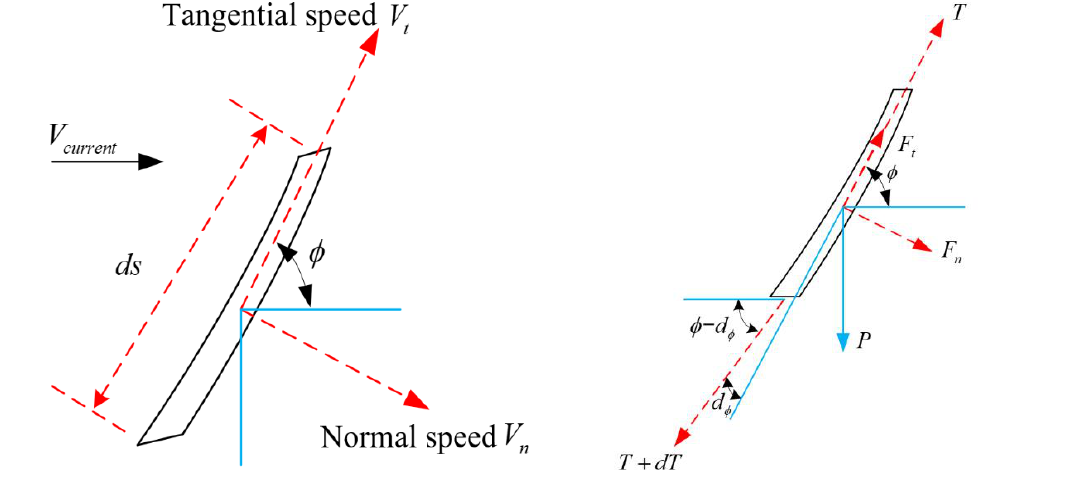
Figure 13. The hydrodynamic force on an EOM cable micro-segment.